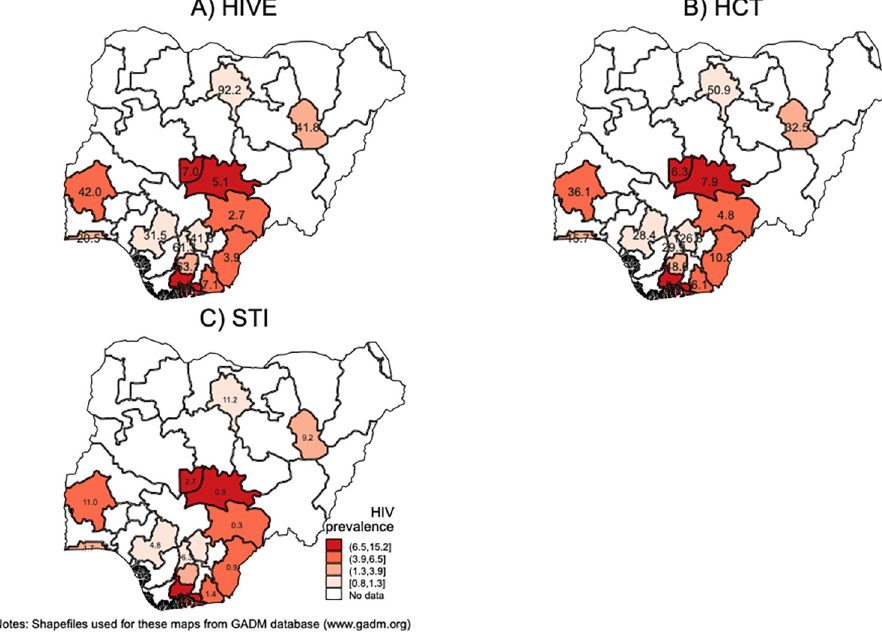
Fig 1. Maps of average unit costs (USD) among CBOs providing HIV prevention services in 2016 and HIV prevalence by Nigerian state for (A) HIV education services, (B) HIV testing and counselling services, and (C) STI treatment referral services. Note: HIV prevalence is depicted in the red scale and shown in percentage. Unit costs are inside the states.